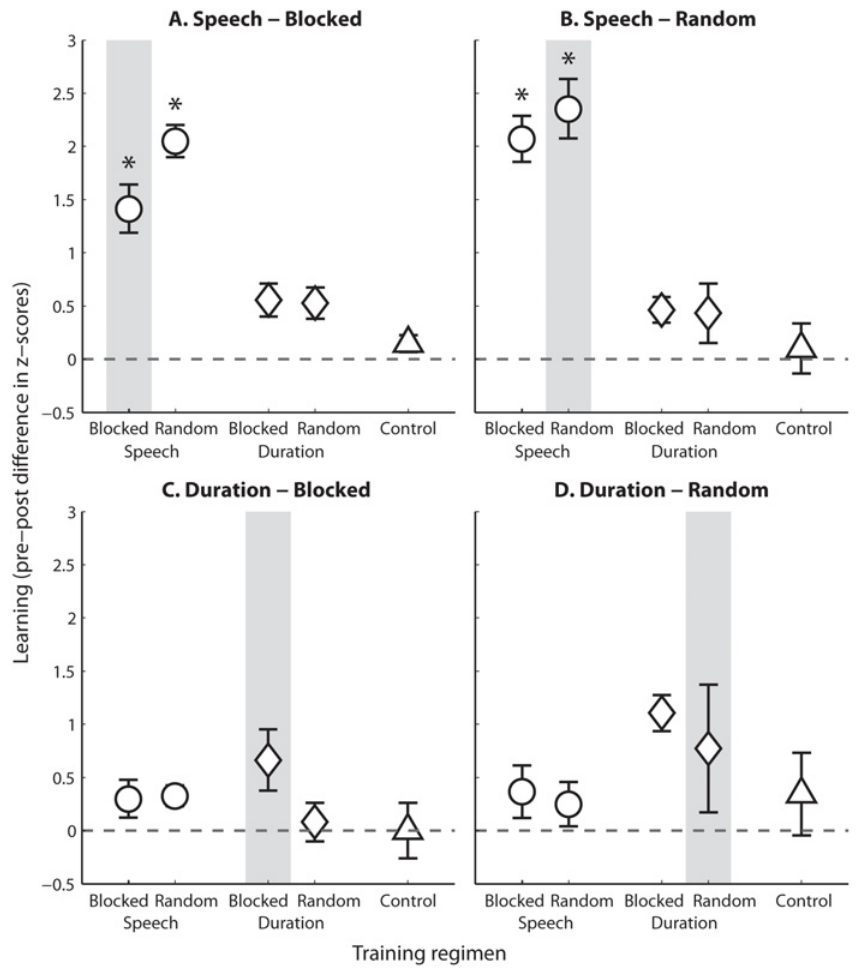
Fig 2. Learning on each stimulus class and testing mode. Learning is shown as the difference between pre- and post-test thresholds. Individual z-scores were calculated with respect to the aggregate pre-test data across all participants tested on each stimulus class and mode (see Methods), and are thus plotted in units of standard deviation from pre-test scores (dashed line at 0) for each group. Data are shown for Blocked (A) and Random (B) Speech, and Blocked (C) and Random (D) Duration, in the groups trained on Blocked and Random Speech, Blocked and Random Duration, and untrained Controls (denoted on the x-axis of each panel). The grey box in each panel indicates the group for which training and testing was on the same regimen. Asterisks demarcate significant learning compared to the Control group (after correction for multiple comparisons, see Table 2). Error bars denote 95% confidence